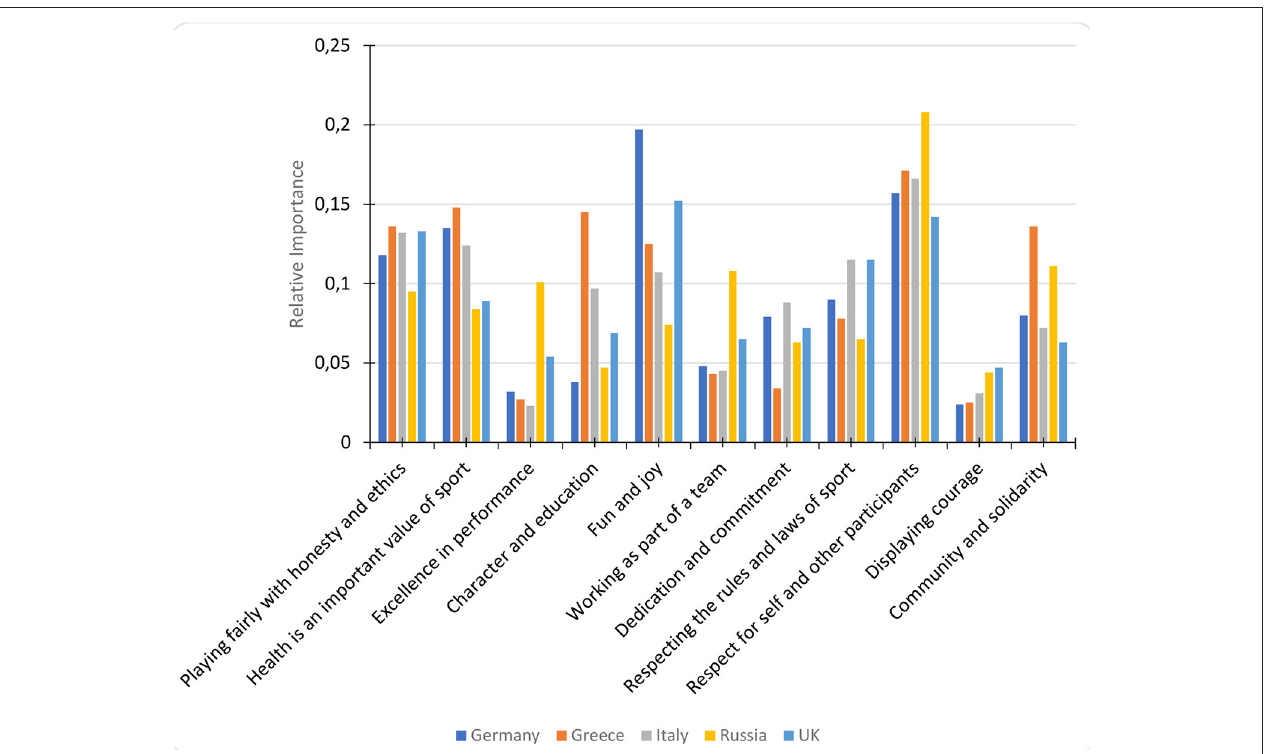
FIGURE 2 | MaxDiff relative importance of Spirit of Sport values by participant